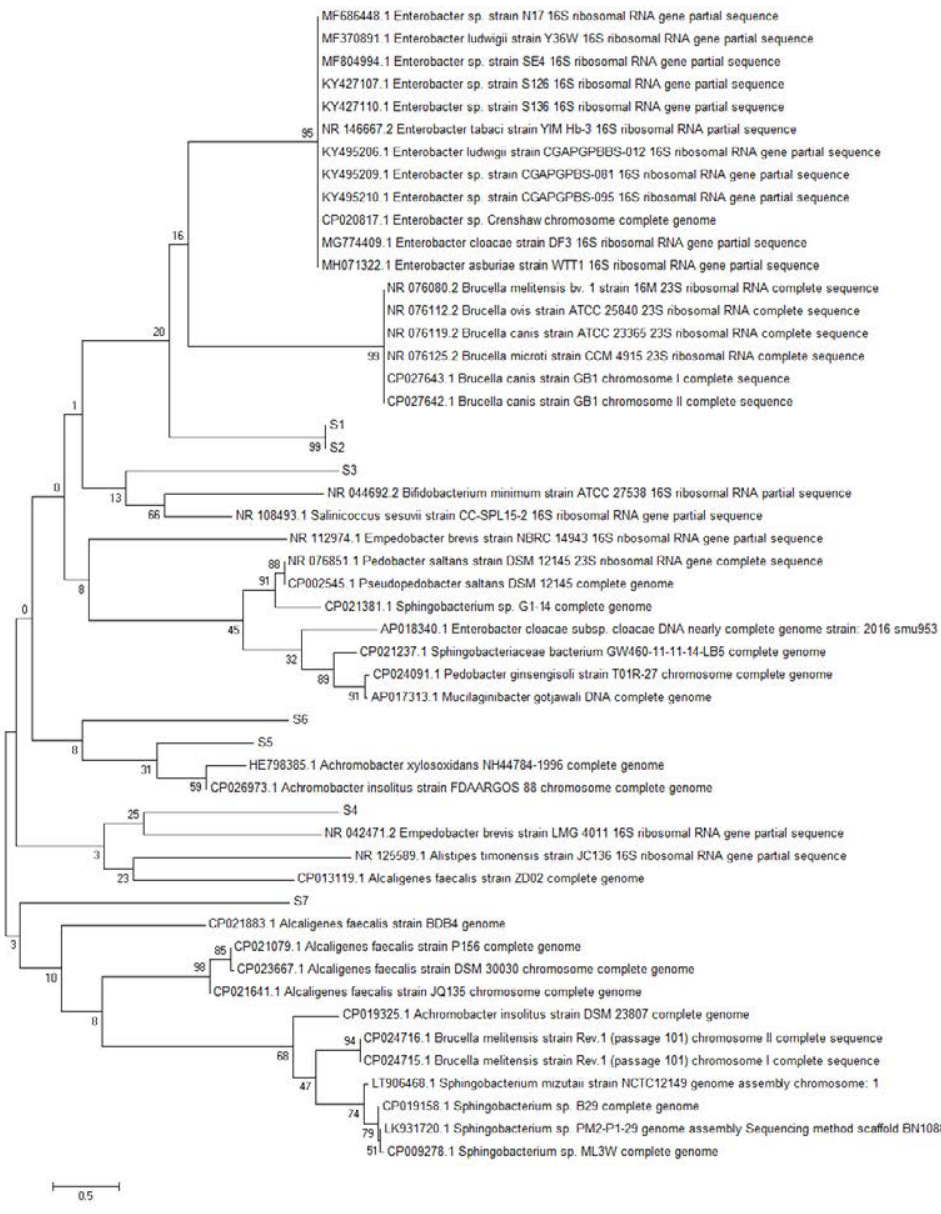
Fig. 2. Reconstruction of the phylogeny tree with neighbor joining model. The phylogeny tree construction uses two models with 1000x boostrap with MEGA